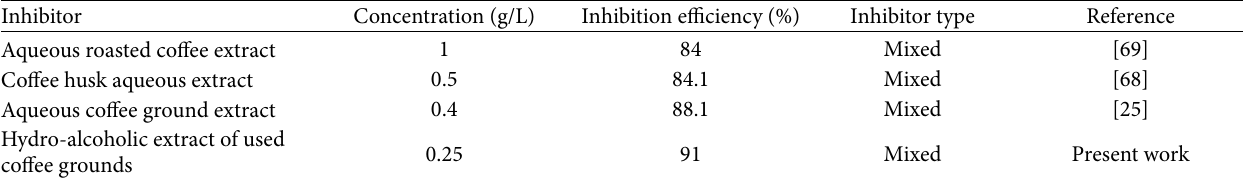
Table 7: Different investigated coffee extracts as an inhibitor for steel corrosion in 1 M HCl